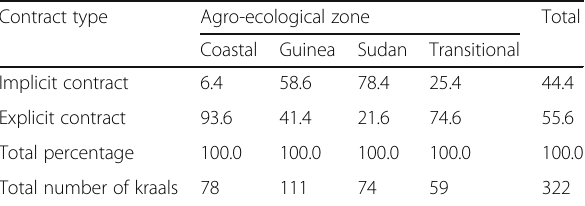
Table 2 Distribution (percentage) of explicit and implicit cattle owner – kraal owner contracts by agro-ecological